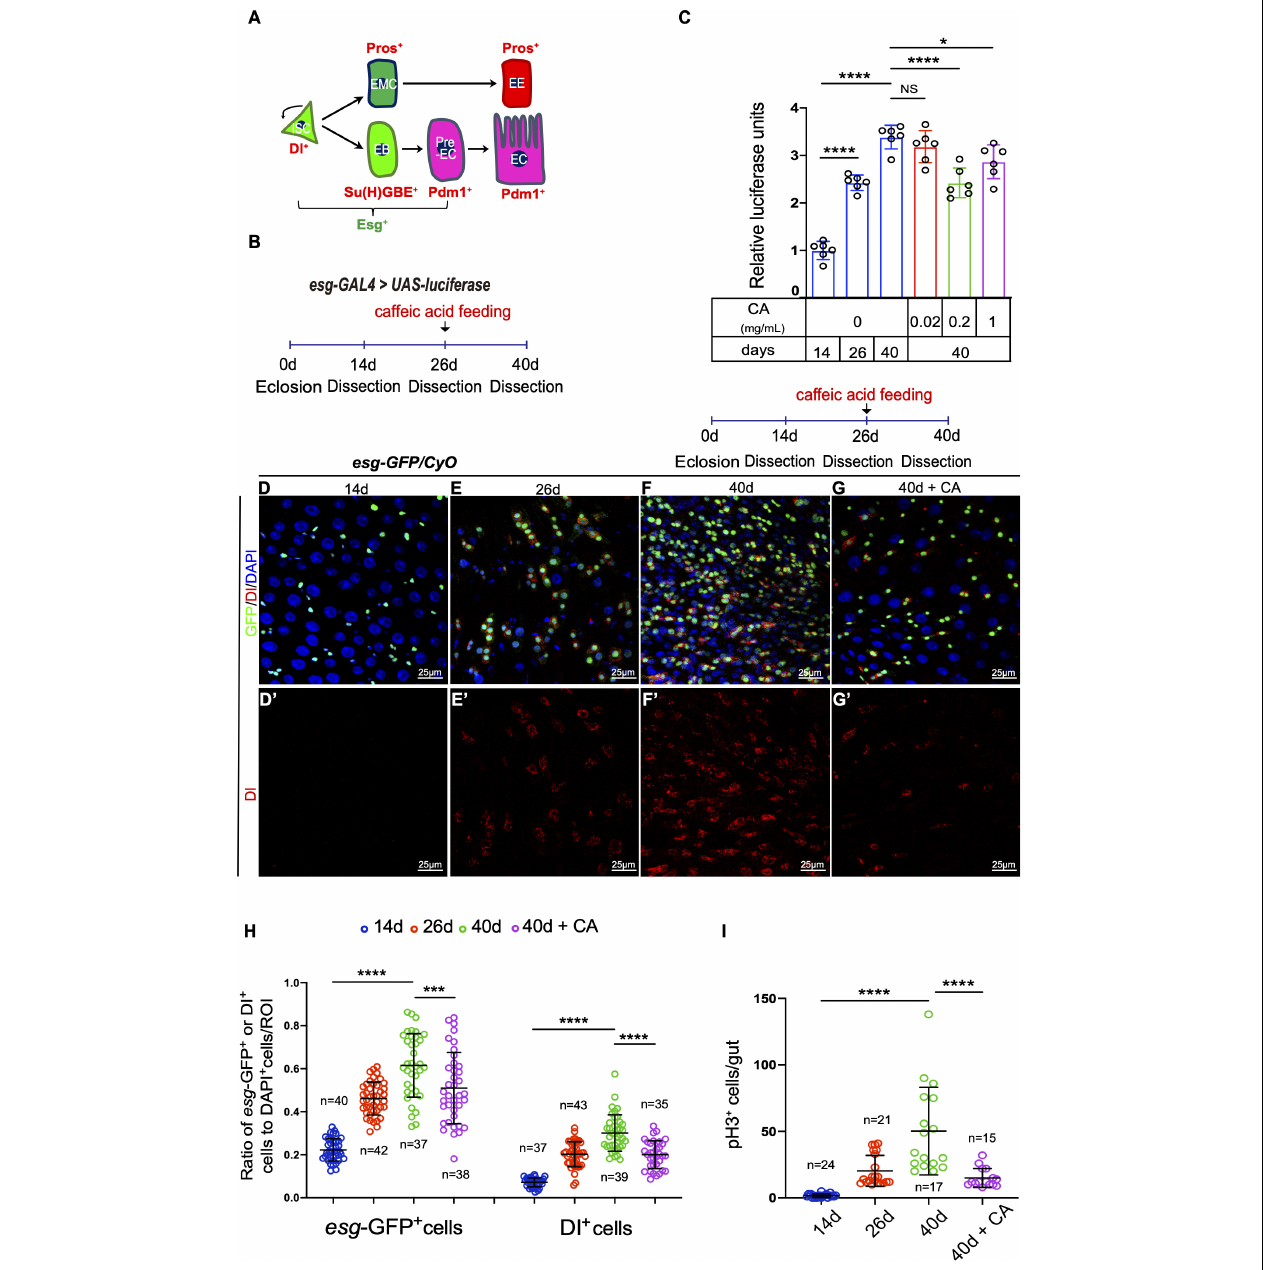
FIGURE 1 | Caffeic acid (CA) supplementation prevents the ISC hyperproliferation in aged Drosophila . (A) Cartoon model of Drosophila ISC lineages. An ISC (Dl + and Esg + ) divides asymmetrically to a diploid precursor enteroblast [EB; Esg + and Su(H)GBE + ] or a diploid precursor enteroendocrine mother cell (EMC). Notch activated EBs (pre-EC; Esg + and Pdm1 + ) further differentiate into enterocytes (ECs; Pdm1 + ), whereas enteroendocrine cells (EEs; Pros + ) are derived from ISCs in a Notch-independent manner via a diploid precursor enteroendocrine mother cell (EMC) intermediate. (B) An illustration of the Drosophila “ esg > luciferase” reporter system. Drosophila with luciferase expression driven by esg -GAL4 was treated with CA on the 26th day after eclosion. After administration for 14 days, the midguts were dissected, and the luciferase activity was measured. (C) Quantification of the luciferase activity of the midguts of flies at 14, 26, and 40 days without CA supplementation (orderly marked with three blue columns) and 40-day flies with three different concentrations of CA (orderly marked with red, green, and purple columns). Error bars represent the standard deviation (SD) of six independent experiments. (D–G) Immunofluorescence images of the R4 region of dissected midguts of 14-day Drosophila (D) , 26-day Drosophila (E) , 40-day Drosophila (F) , and 40-day Drosophila with 0.2 mg/mL CA supplementation (G) . esg -GFP (green; ISC and EB markers) and Dl (red; ISC marker). Panels (D–G) represent merged images and panels (D’–G’) are for Dl (red) only. (H,I) Quantification of the number of esg -GFP + , Dl + , and pH3 + cells in experiments (D–G) . N (from left to right) = 40, 42, 37, 38, 37, 43, 39, and 35 in panel (H) . N (from left to right) = 24, 21, 17, and 15 in panel (I) . DAPI stained nuclei are shown in blue in panels (D–G) . Scale bars represent 25 µ m in panels (D–G) . Error bars represent SDs. One-way ANOVA test, * P < 0.05, *** P < 0.001, **** P < 0.0001, and non-significant (NS) represents P > 0.05.